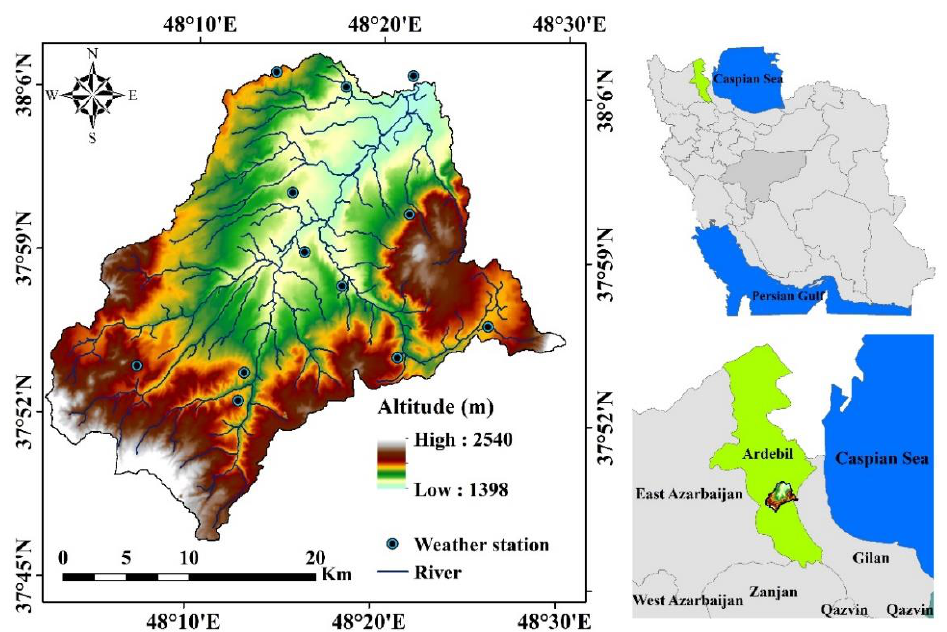
Figure 1. Location of the study area in the Kozetopraghi catchment in the North of Garasou basin, Iran. Location, elevation, stream and weather station are shown.